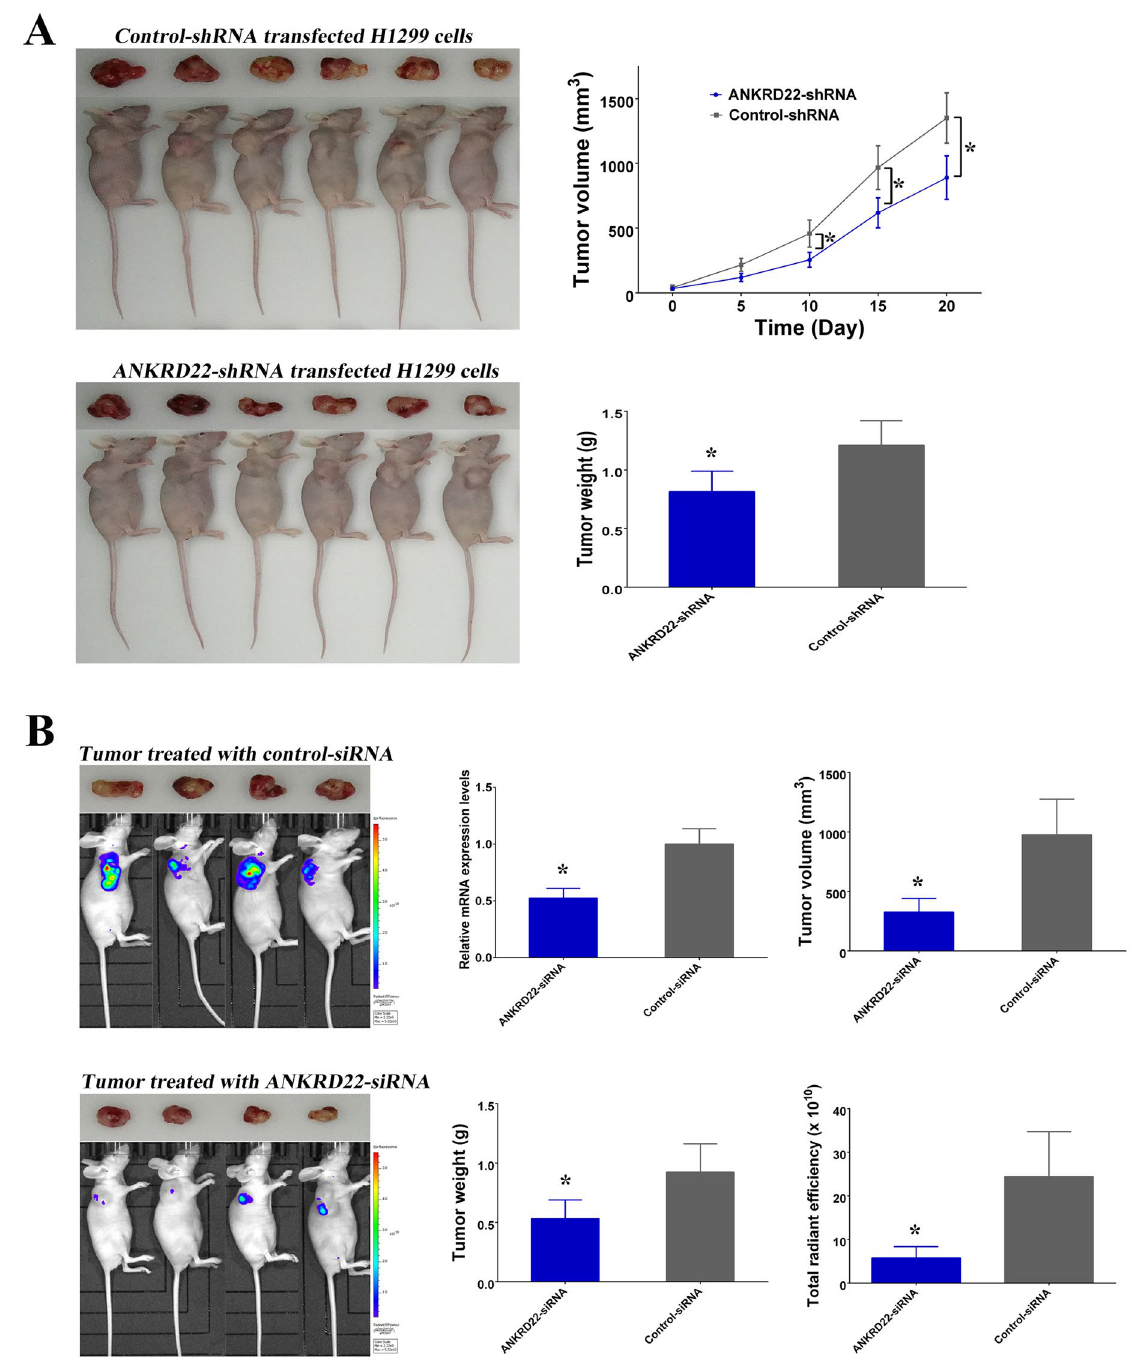
Figure 5. ANKRD22 influenced the growth of xenograft tumor. ( A ) Knockdown of ANKRD22 in H1299 cells by transfection with ANKRD22-shRNA decreased the volumes and weights of xenograft tumors. ( B ) Direct injection of ANKRD22-siRNA inhibited the growth of xenograft tumor in vivo . ( * P <